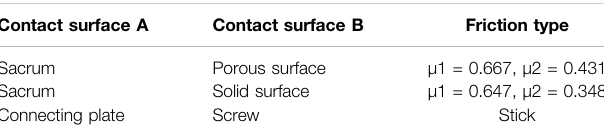
TABLE 2 | Friction types between components. Contact surface